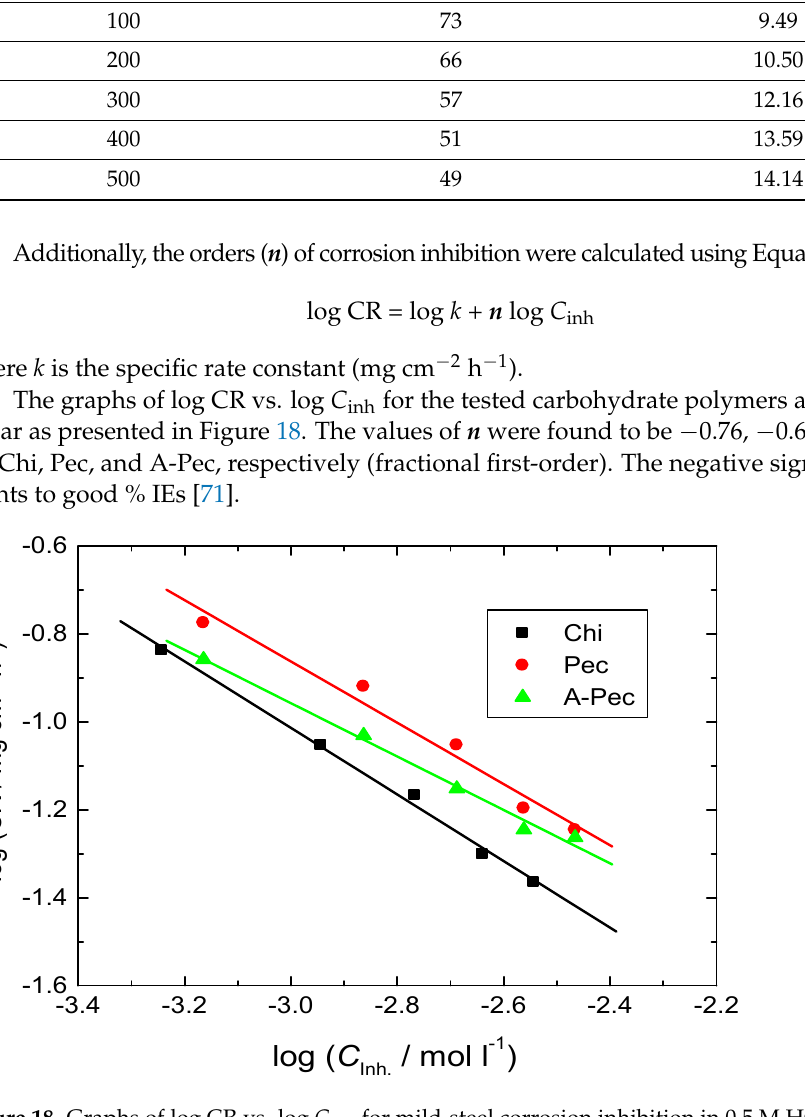
Figure 18. Graphs of log CR vs. log C inh for mild-steel corrosion inhibition in 0.5 M HCl solution by the tested carbohydrate polymers at 303 K.